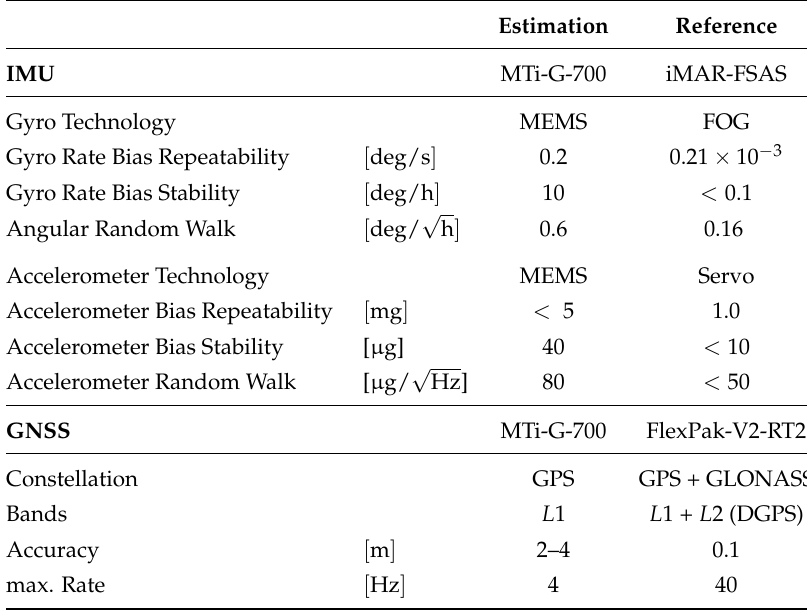
Table 1. Sensor specifications for estimation and reference